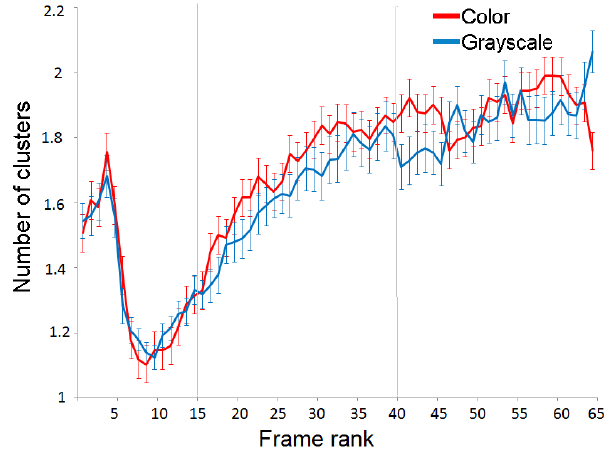
Figure 8 . Mean number of clusters according to the stimulus condition over time (frame rank).Error bars represent the standard error (standard deviation divided by the root square of the number of